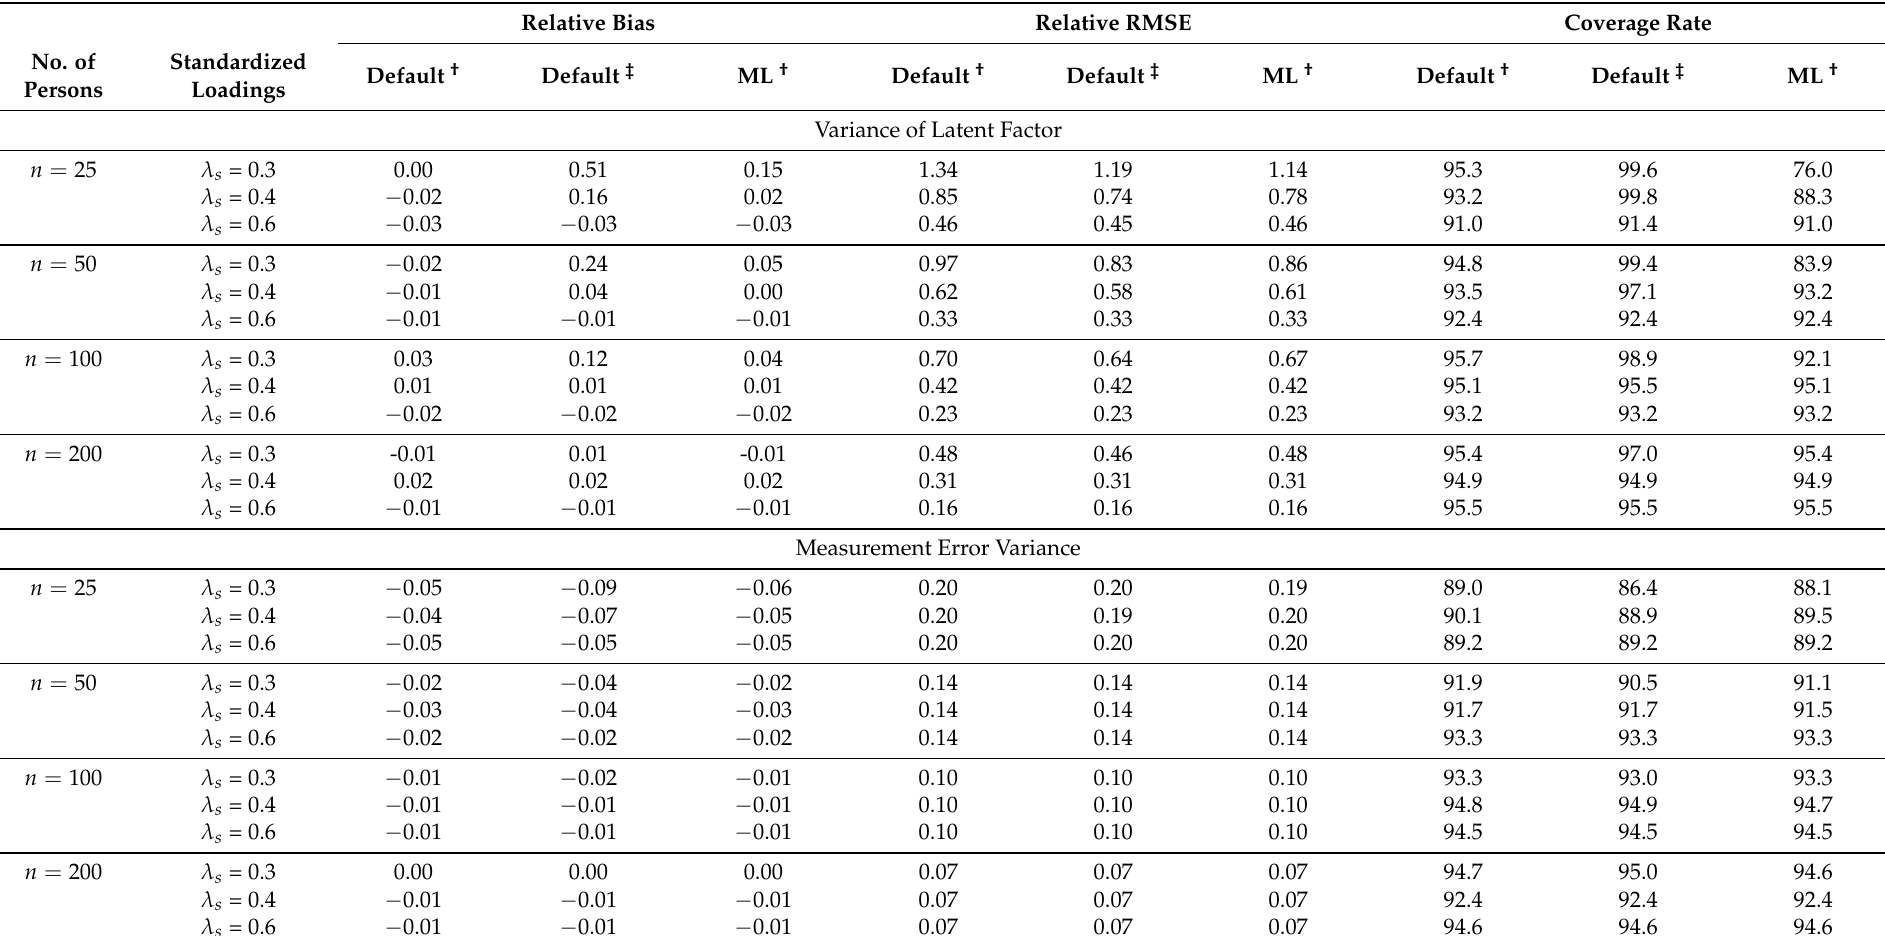
Table 2. Simulation study results: Relative bias, relative root mean squared error (RMSE), and coverage rate from estimating the variance of the latent factor and the measurement error variance with M plus ’ default procedure and the maximum likelihood (ML)